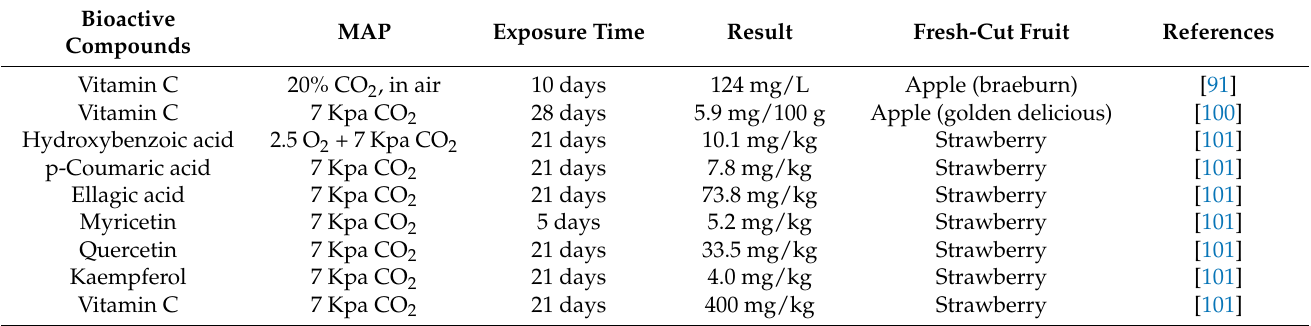
Table 2. Bioactive compounds in the fresh-cut fruits after the use of MAP during